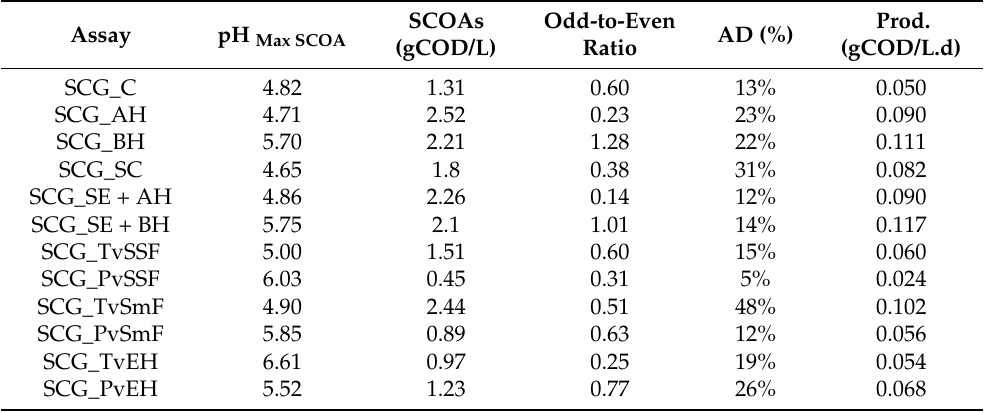
Table 4. Overview of the assays’ performances (maximum SCOA concentration and its odd-to-even carbon ratio, acidification degree, and